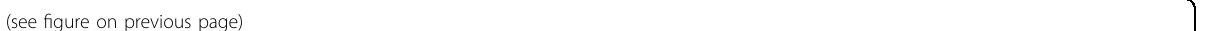
Fig. 6 Effects of maternal PRS and drug treatment, and offspring exposure to behavioral stress on Crhr1 and mir-34a expression in mPFC of adult F1 and F2 offspring. a In F1-VEH males, direct exposure to high-stress testing conditions increases, whereas maternal PRS decreases, Crhr1 expression (2 × 2 ANOVA, cohort F 1,22 = 117.08, p < 0.00001; group F 1,22 = 15.6, p < 0.001). b In F1-VEH females, high-stress test exposure increases Crhr1 expression, whereas maternal PRS increases Crhr1 expression in low-stress but decreases it in high-stress rats (group × cohort F 1,23 = 19.2, p < 0.001). c In F1-VEH males, high-stress test exposure increases mir-34a expression (2 × 2 ANOVA, cohort F 1,23 = 10.55, p < 0.01). d In F1-VEH females, high-stress test exposure increases mir-34a expression in F1-C rats, and maternal PRS decreases expression in high-stress rats only (2 × 2 ANOVA, group× cohort F 1,21 = 7.06, p < 0.05). e In low-stress F1 males, PRS leads to a decrease in Crhr1 , and maternal FLX treatment increases Crhr1 expression (2 × 3 ANOVA, group F 1,34 = 16.5, p < 0.001; drug F 2,34 = 4.8, p < 0.05). f In low-stress F1 females, maternal PRS and/or drug treatment increase Crhr1 expression (2 × 3 ANOVA, group × drug F 2,32 = 7.9, p < 0.01). g In high-stress F1 males, maternal PRS decreases Crhr1 expression, and this is reversed by maternal FLX treatment (group × drug F 2,35 = 3.1, p = 0.059). h In high-stress F1 females, maternal PRS and/or FLX treatment decreases Crhr1 mRNA (group F 1,35 = 4.9, p < 0.05; drug F 2,35 = 42.2, p < 0.001). In F2 offspring, PRS decreases Crhr1 ( i ) and mir-34a ( j ) expression in male and female offspring (1-way ANOVAs Crhr1: M F 1,10 = 5.43, p < 0.05; F F 1,10 = 5.6, p < 0.05; mir-34a: M F 1,11 = 5.42, p < 0.05; F F 1,9 = 6.3, p < 0.05). Data presented as means and standard errors of fold-change. * p < 0.05, ** p < 0.001, post-hoc or main effects relative to C-VEH controls. ^ p < 0.05, post-hoc relative to high-stress F1-VEH or